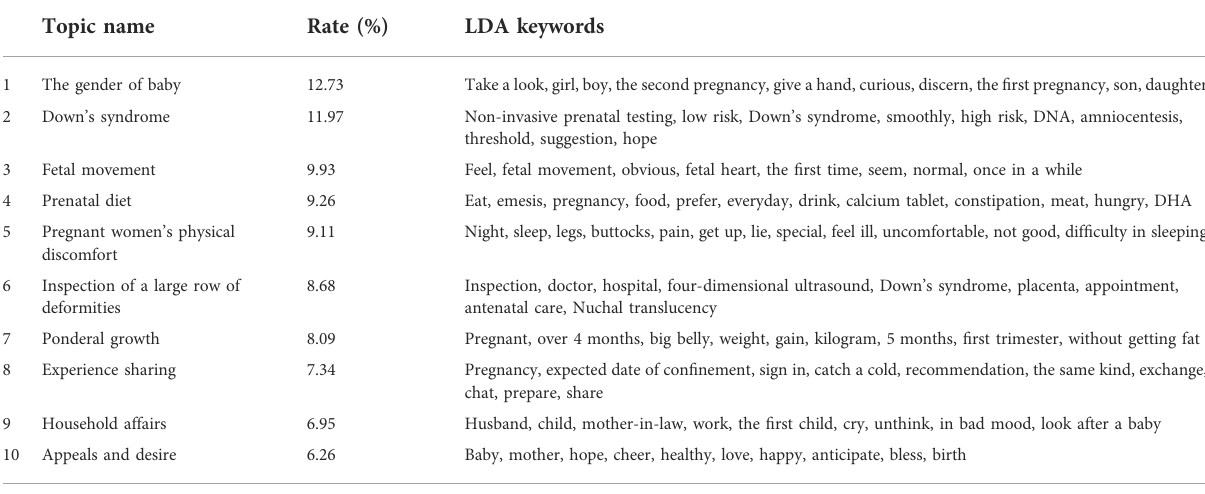
TABLE 8 Topics in the fi fth month of pregnancy.